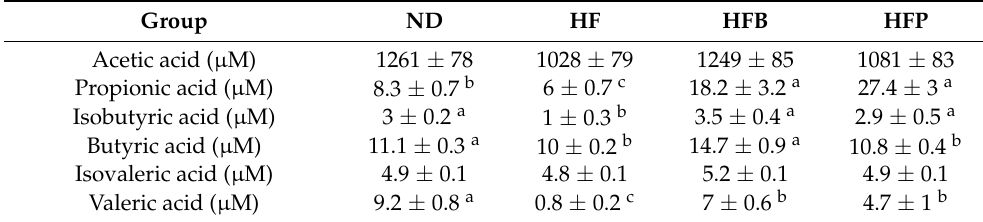
Table 3. Plasma SCFA levels of male offspring at 12 weeks of